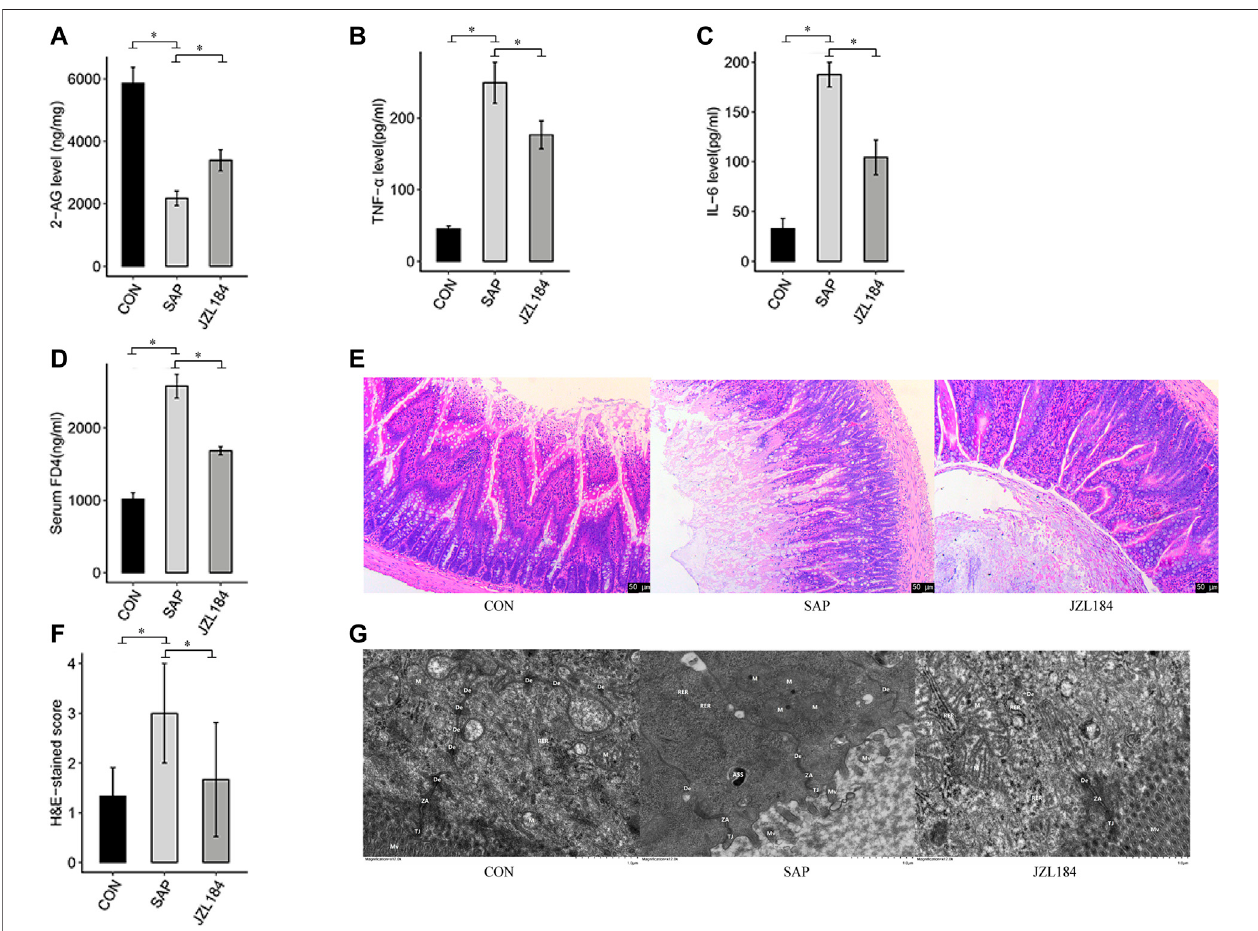
FIGURE 1 | MAGL inhibitor affect intestinal permeability of rats with SAP. (A) 2-AG levels detected in each group. The levels of 2-AG were signi fi cantly lower in the SAP groupthan in thecontrolgroup ( p < 0.05) and JZL184 partially restored 2-AG levels inthe SAPgroup; (B) IL-6 levels detected in each group. The concentrationsof IL-6washigherintheSAPgroupthaninthecontrolgroup( p < 0.05).JZL184decreasedIL-6levels; (C) TNF- α levelsdetectedineachgroup.TheconcentrationsofTNF- α was higher in the SAP group than in the control group ( p < 0.05). JZL184 decreased TNF- α levels; (D) FD4 concentrations detected in each group. The FD4 concentrationwashigherintheSAPgroupthaninthecontrolgroup( p < 0.05).JZL184decreasedserumFD4levels( p < 0.05); (E) RepresentativeHE-stainedimagesof ileal sections in each group (original magni fi cation, ×100). No obvious intestinal mucosal injury was found in the control group. However, there were signs of intestinal injury in the SAP group; (F) Pathological scores for the ileum in each group. The intestinal tissues of SAP rats treated with JZL184 displayed a lesser degree of morphologicalchangesandlowerpathologicalscoresthanthoseoftheSAPgroup( p < 0.05); (G) TheultrastructureofIECsobservedbyTEMineachgroup.Noobvious intestinal barrier damage was found in the control group, whereas the intestinal barrier was severely damaged in the SAP group. These histopathological changes were ameliorated by JZL184. n = 3 in each group. * p < 0.05, ** p < 0.01.